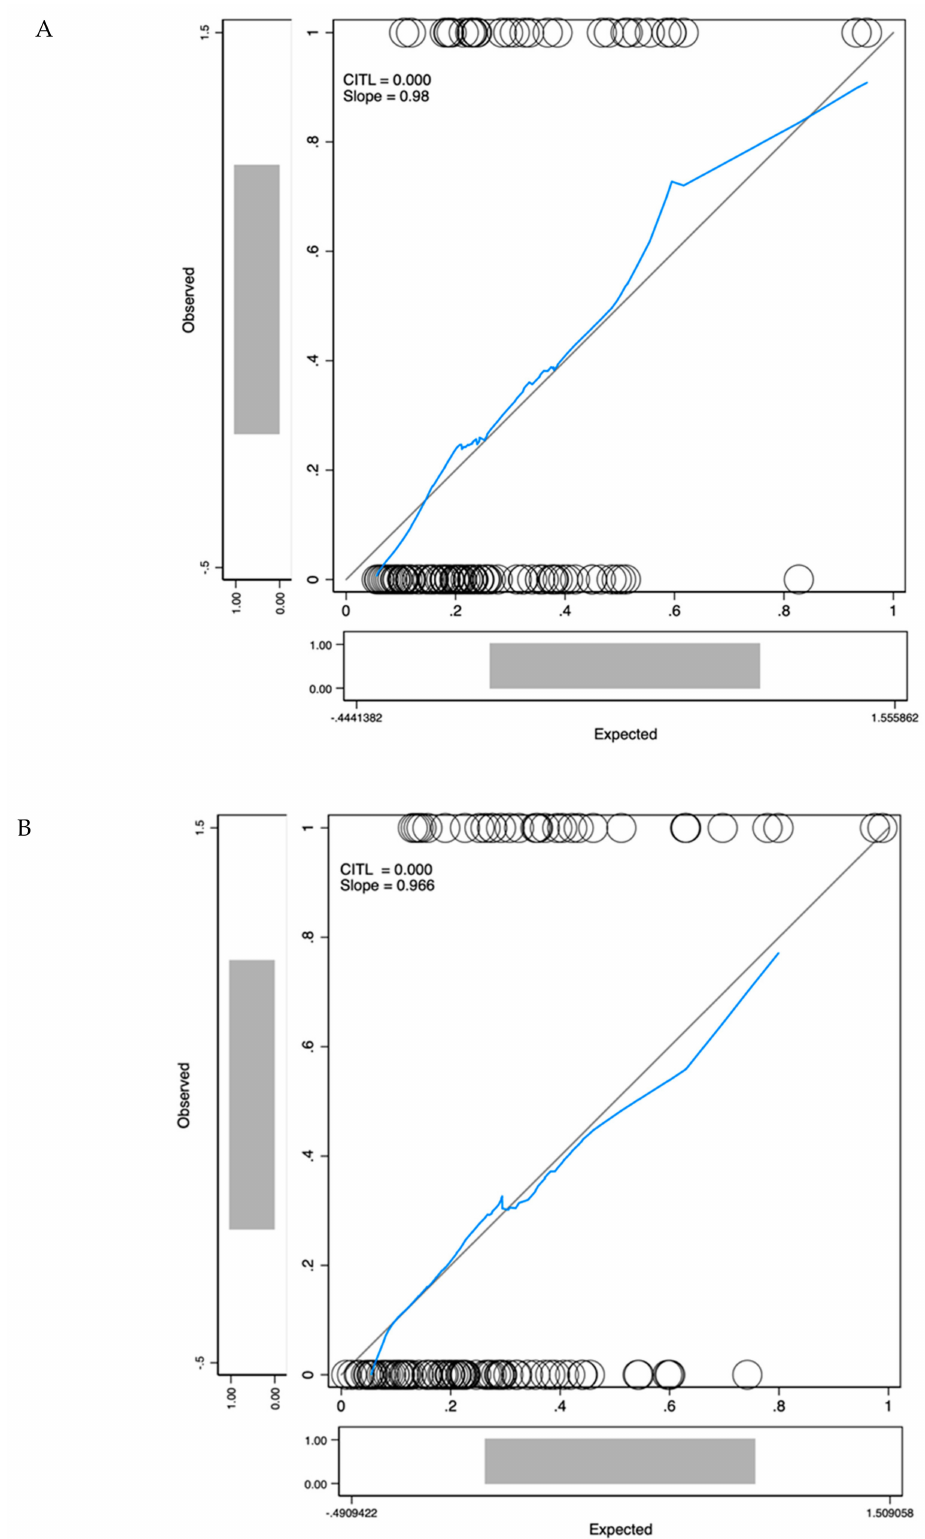
Figure 5. Calibration curves for the biomarker model ( A ) and the clinical model ( B ). The x -axis represents model predictions, the y -axis the observed diagnosis of high-grade cancer. Calibration in the large (CITL) measures whether the predicted prevalence was less than (CITL < 0) or greater than (CITL > 0) the observed